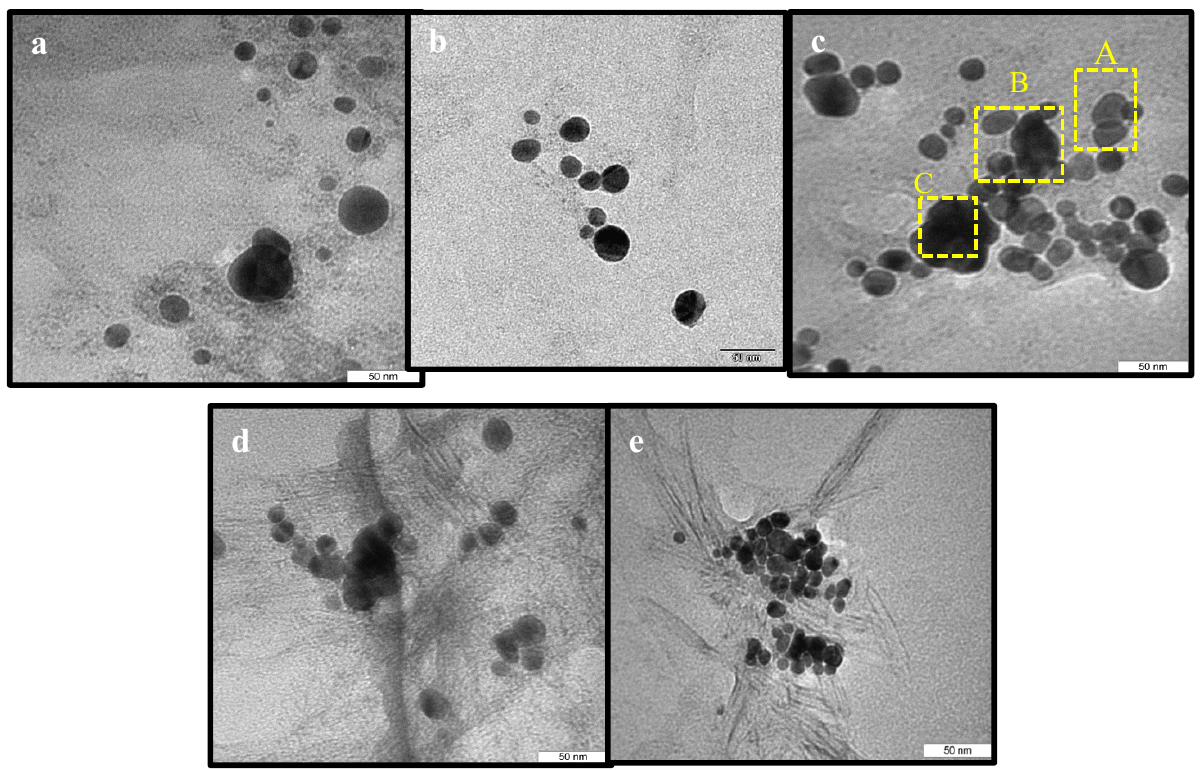
Figure 2. TEM images of ZnO-Ag/CNCs of ( a ) 1.0. ( b ) 3.0. ( c ) 5.0. ( d ) 7.0. ( e ) 10.0. wt% of Ag